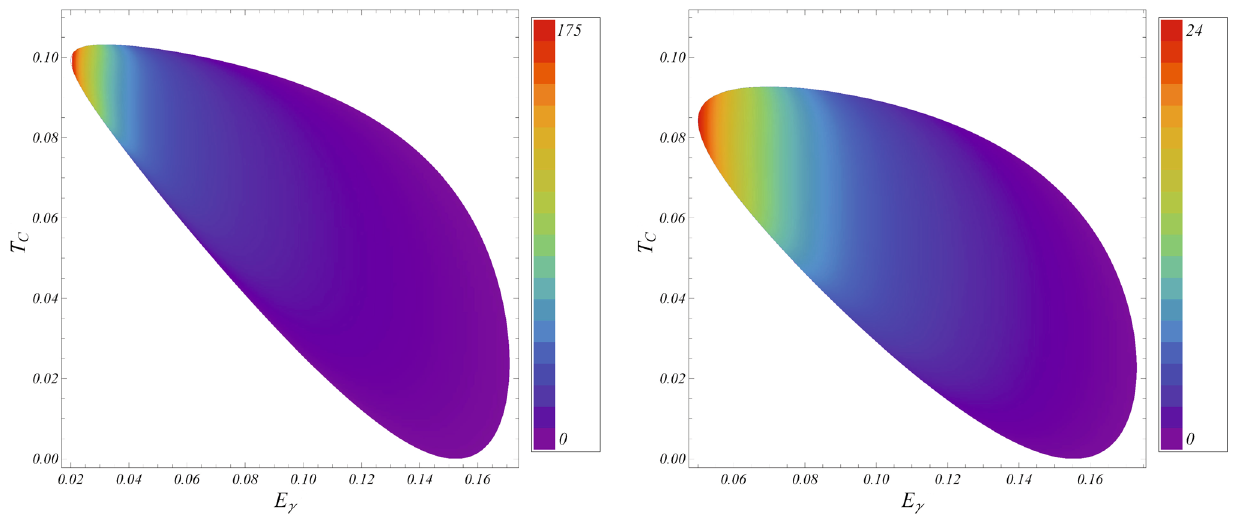
Fig. 3 Dalitz plots for the interference differential decay rate of K S → π + π − e + e − in the ( E γ , T c ) plane for q = 20 MeV (left panel) and q = 50 MeV (right panel). Numbers are given in units O ( p 4 ) corrections. In (19) we have used N ( 0 )